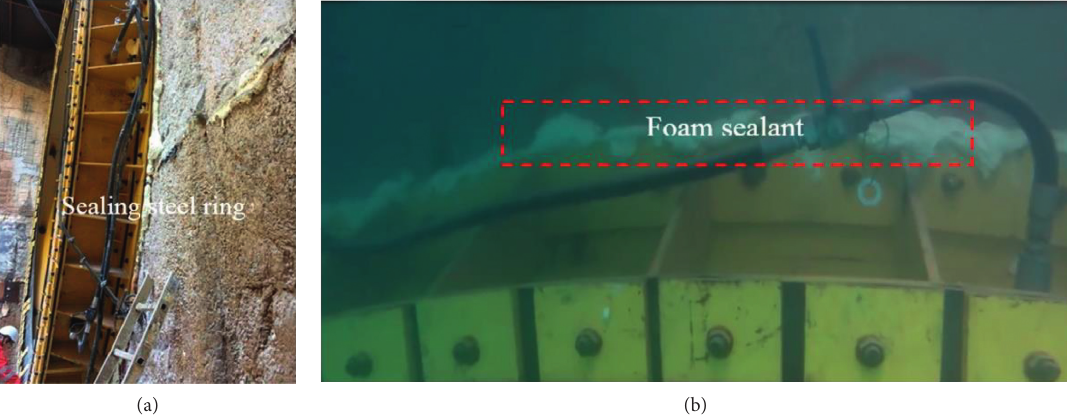
Figure 10: Portal sealing: (a) installation of the sealing steel ring and (b) foam sealant between the steel sealing ring and the underground diaphragm